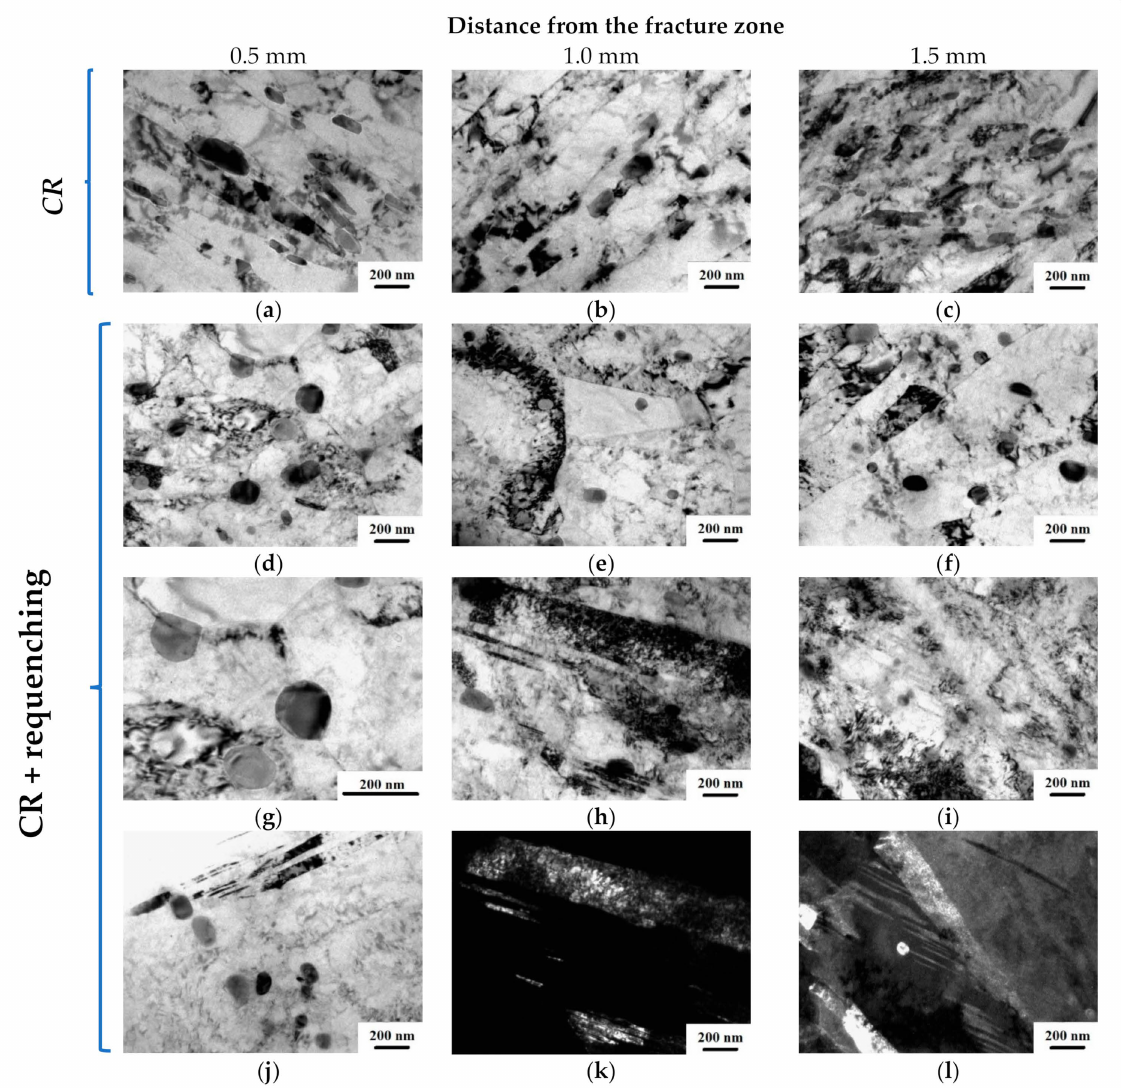
Figure 9. Microstructure of the CR and CR + requenching samples after fatigue tests at a distance of 0.5, 1.0, and 1.5 mm from the fracture zone. TEM images: ( a – j ) bright field, ( k , l ) dark field.